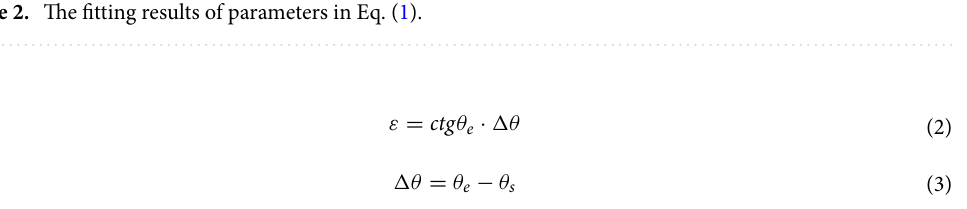
Table 2. The fitting results of parameters in Eq.